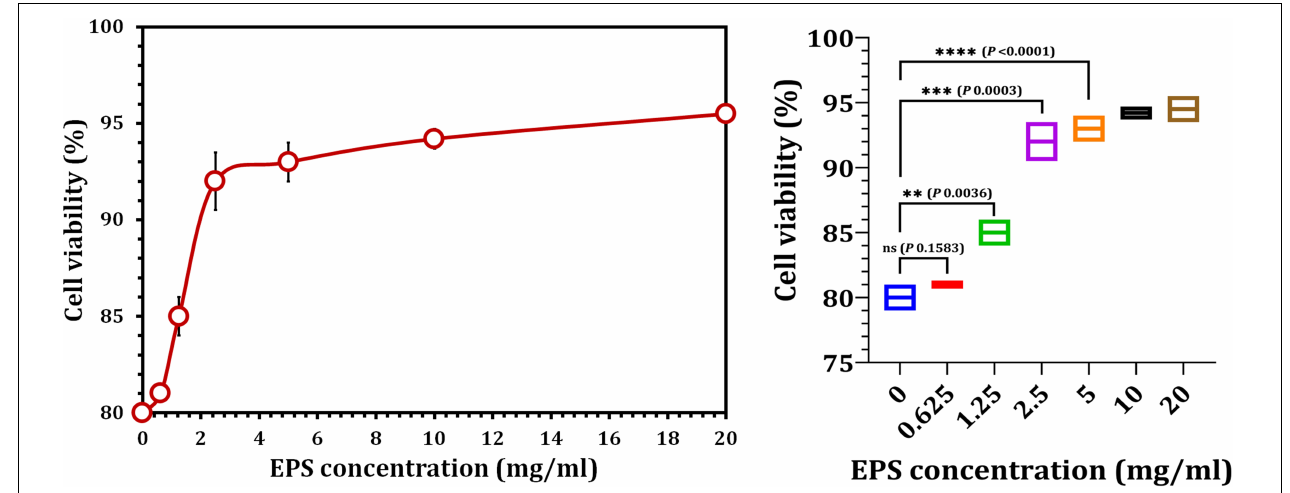
Figure 9 | The effect of crude EPS 5 derived from L. delbrueckii ssp. bulgaricus DSM 20081 T on cell viability in hPDLF cells using MTT assay.